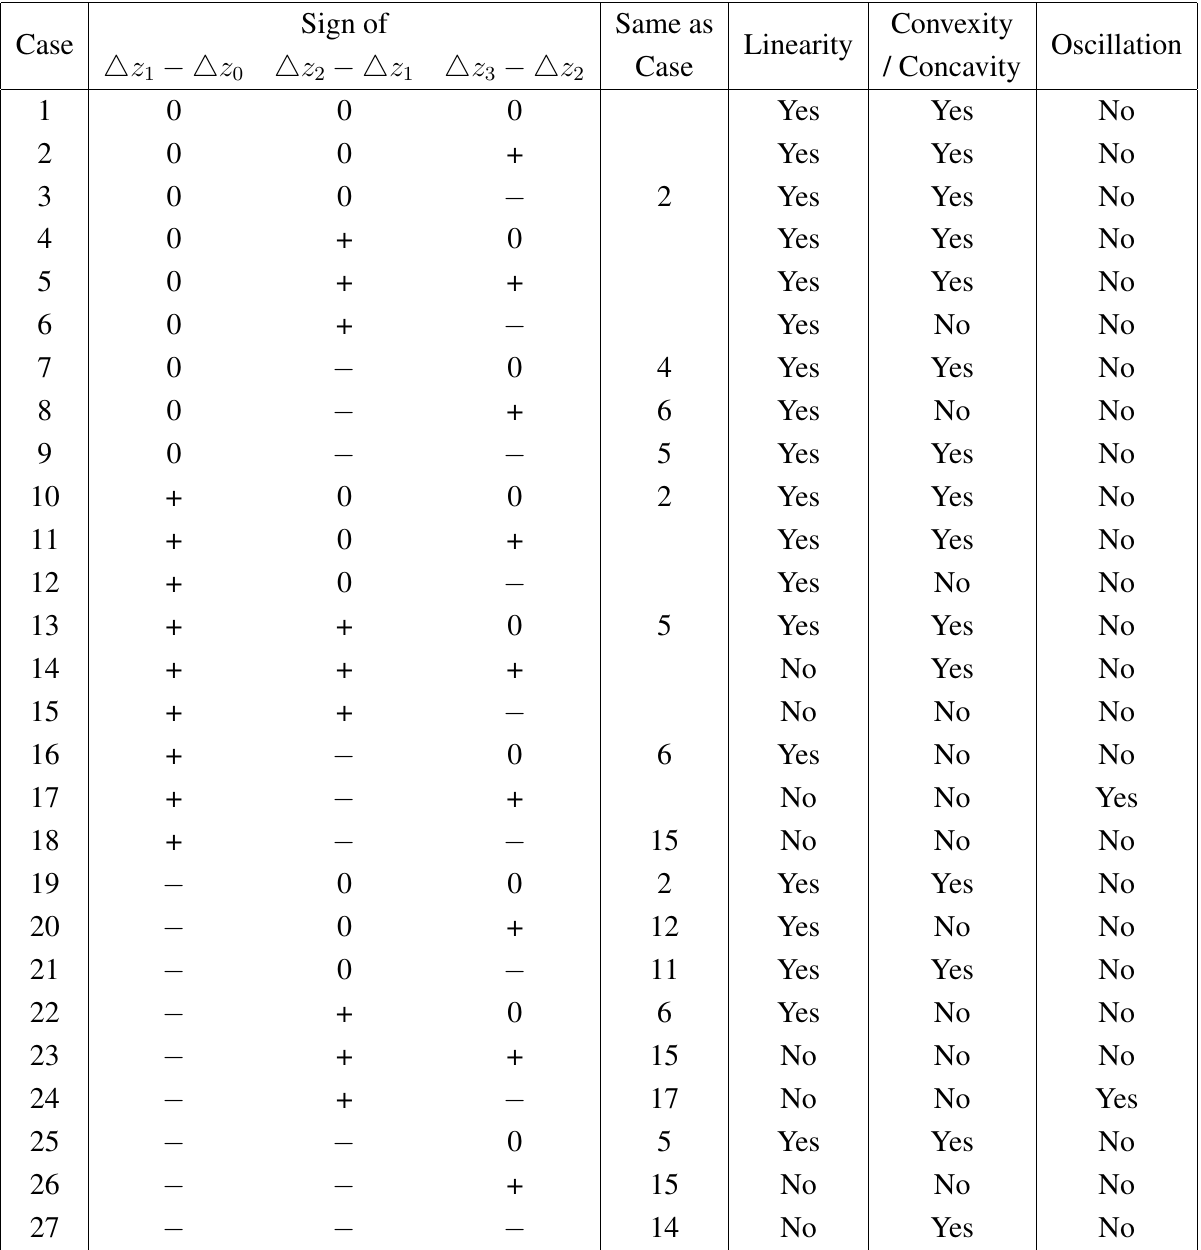
Table 1 . 27 cases in the 5-point window